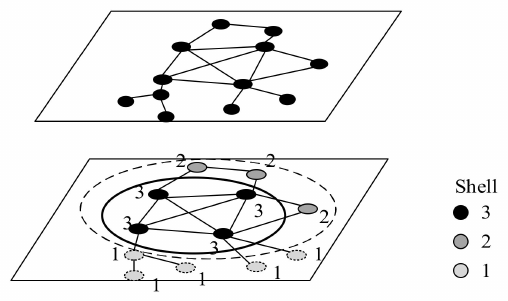
Figure 2. Decomposing the keyword network based on K (k > K).